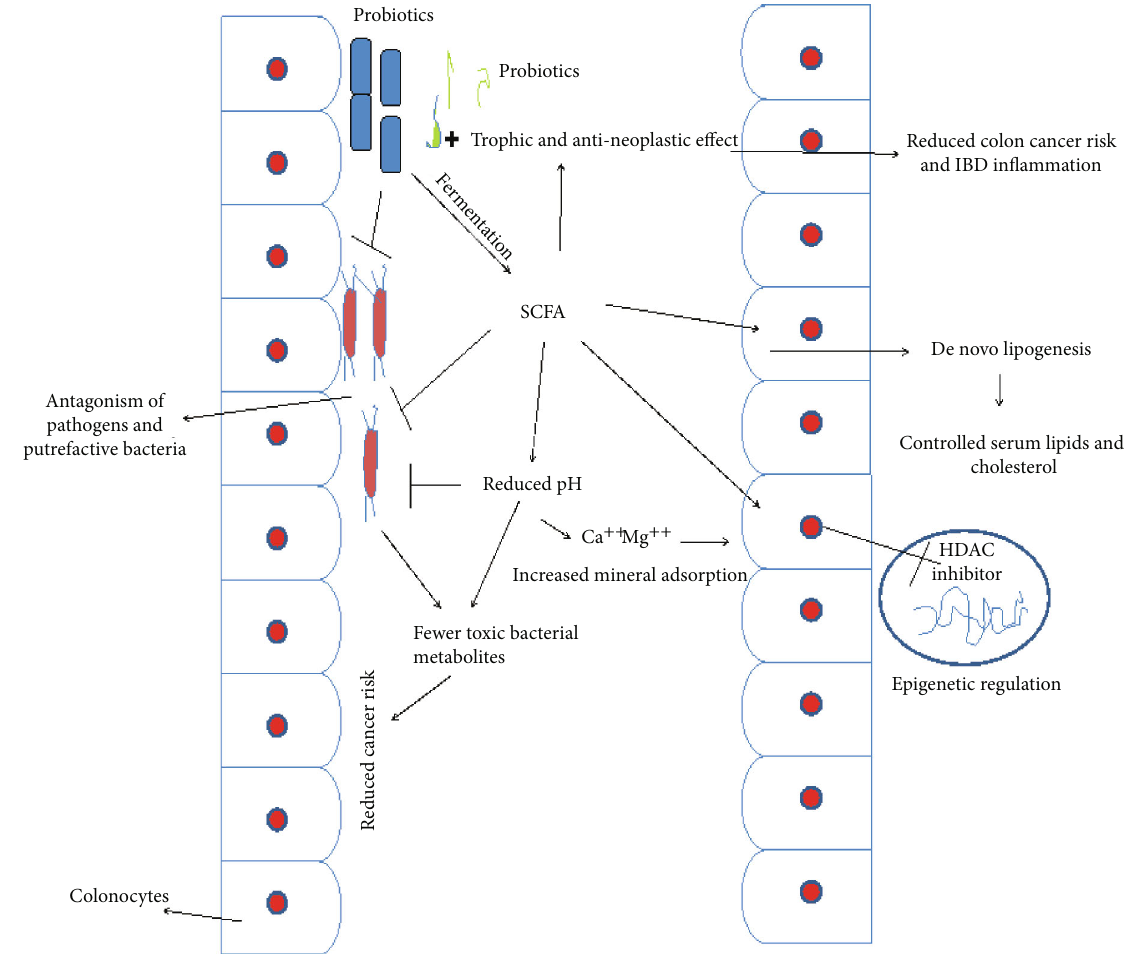
Figure 2: Role of probiotic ’ s metabolites as epigenetic strategy for controlling hypercholesterolemia and colon